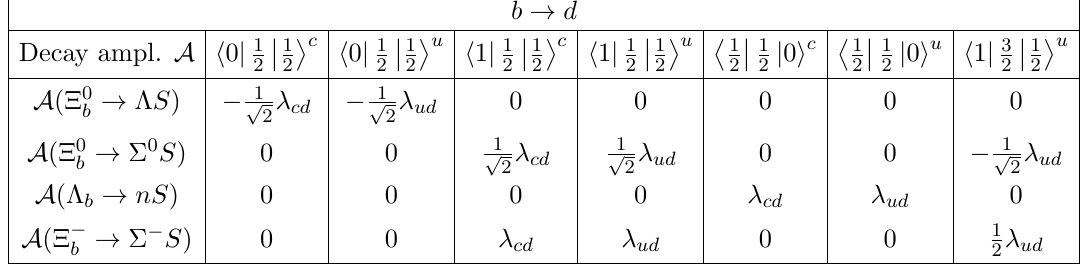
Table 4. Isospin decomposition for b ! d transitions.